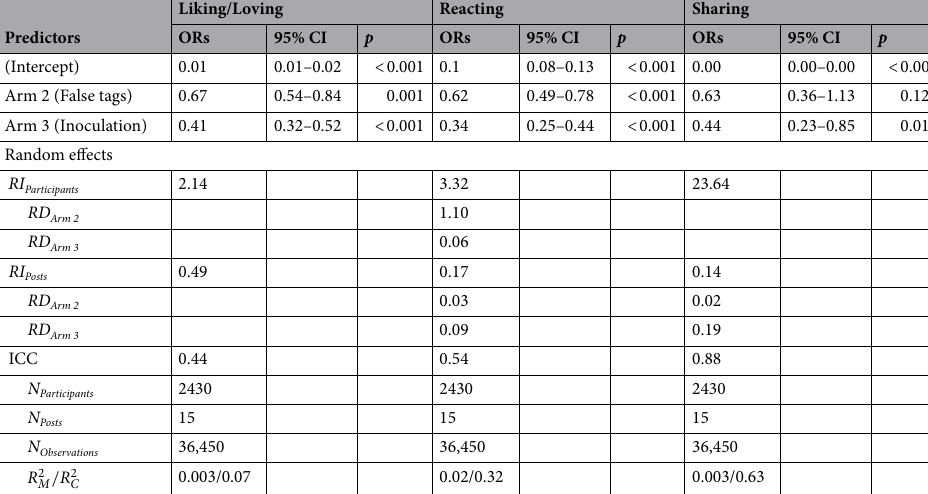
Table 2. Primary and secondary models’ estimates. RI refers to random intercepts; RD refers to random differences; ICC refers to intra-class correlation coefficient; R 2 conditional R calculated using the delta method 50